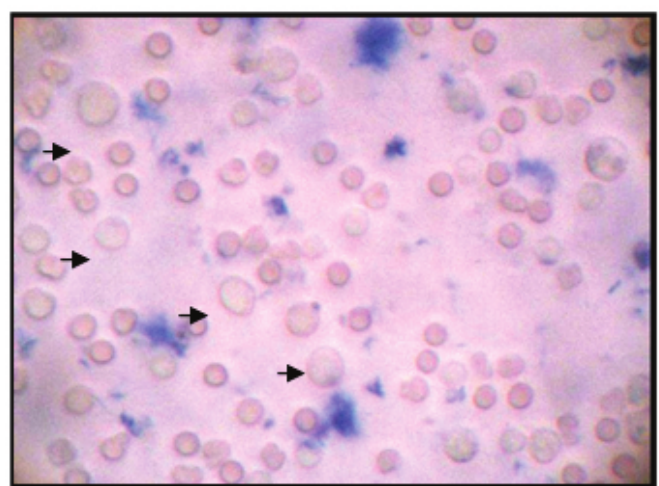
FIGURE 5 - Figures represent the cell viability of CTF with trypan Blue. The arrows represent CTF who are